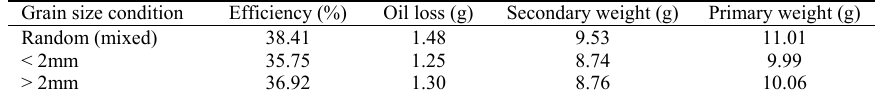
Table 1: Efficiency of grained samples in SCR of 2